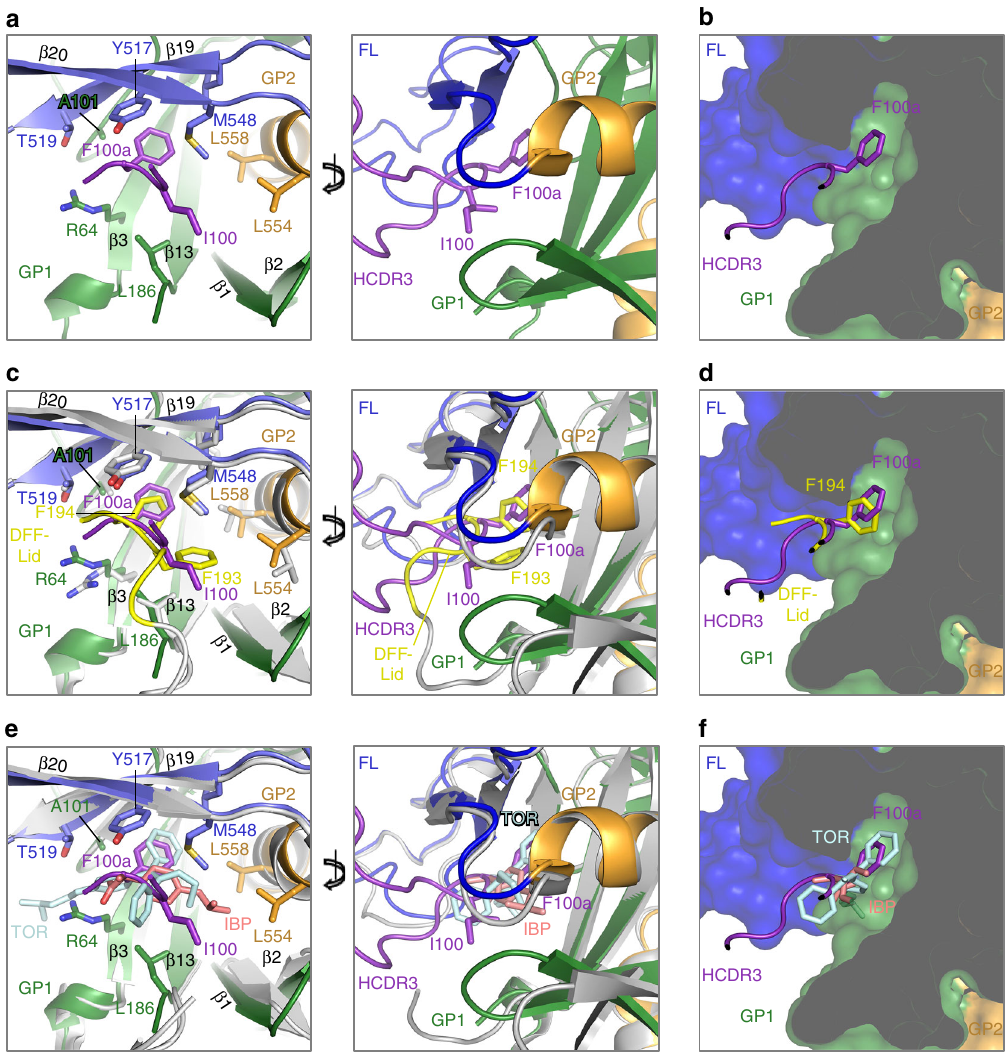
Fig. 5 CA45 de fi nes an inhibitor-binding cavity on GP as a site of immune vulnerability. a The CA45 HCDR3 loop (purple) inserts into the DFF inhibitor- binding cavity located beneath strand β 19 – β 20 of the fusion loop stem (blue). GP1 is colored green, GP2 orange, and fusion loop (FL) blue. Cartoon representation of front of cavity with apical residues of HCDR3 shown (left) and rotated with a more extensive view of HCDR3 (right). b Cross-sectional view of right panel in a , with GP shown in surface representation to reveal DFF cavity. c Superposition of unliganded GP (gray; PDB ID 5JQ3) onto CA45- bound GP (representations in left and right panels are as described in a ). Residues of the “ DFF lid ” of unliganded GP1 are shown in yellow, with residues F193 and F194 shown in stick representation. d Cross-sectional view of right panel in c , with GP shown in surface representation. e Superposition of toremifene- and ibuprofen-bound GP structures (gray; PDB IDs 5JQ7 and 5JQB, respectively) onto CA45-bound GP structure, with toremifene (TOR) shown in pale cyan and ibuprofen (IBP) shown in salmon (representations in left and right panels are as described in a ). f Cross-sectional view of right panel in e , with GP shown in surface